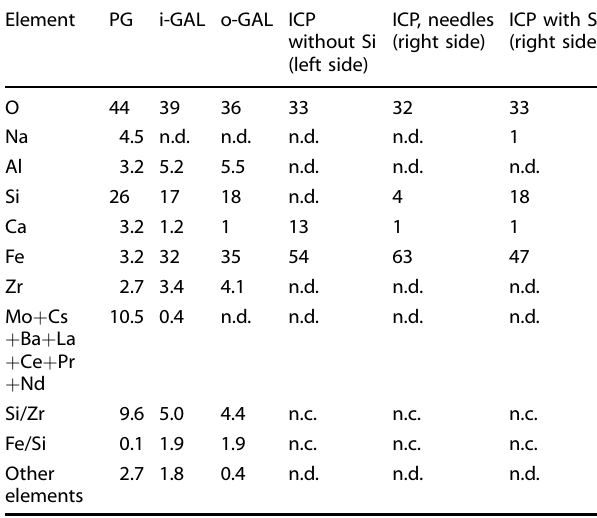
Table 1. SEM-EDS composition ( σ < 0.5) in wt.% obtained in pristine glass, in the inner and outer GAL (analyses performed in the white squares in Fig. 2b), and in the ICP (Fig. 7).